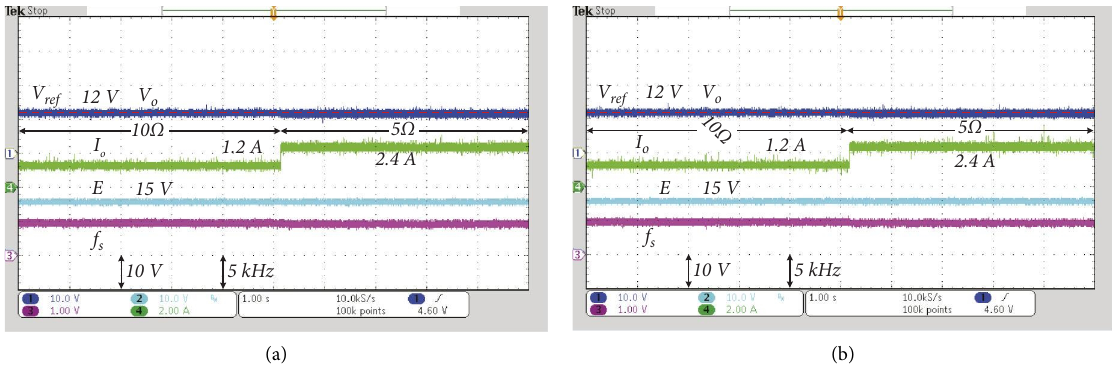
Figure 12: Proposed control: (a) without FCL; (b) with FCL.